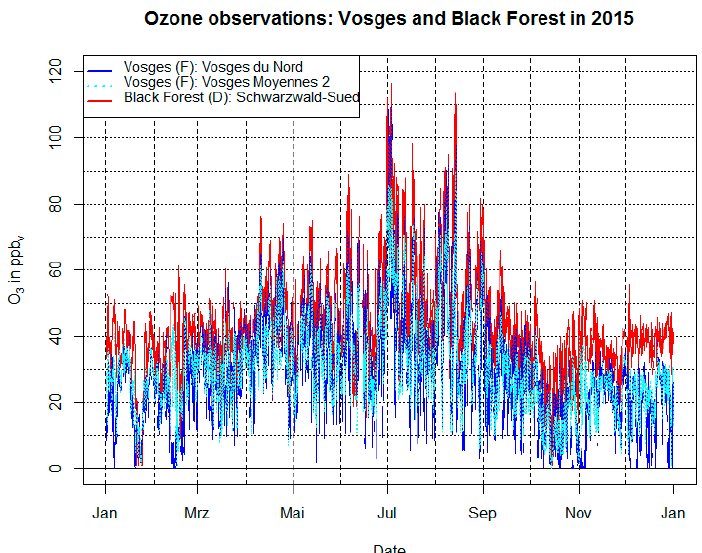
Figure 1. Hourly observations of background boundary layer atmospheric ozone volume mixing ratio values in the Alsatian Vosges (‘Vosges du Nord’ and ‘Vosges Moyennes 2’, courtesy of Pierre Robellet, l'Association pour la Surveillance et l'Etude de la Pollution Atmosphérique en Alsace (ALPA)) and the Black Forest (‘Schwarzwald-Sued’), resolved by the local agencies for air quality.